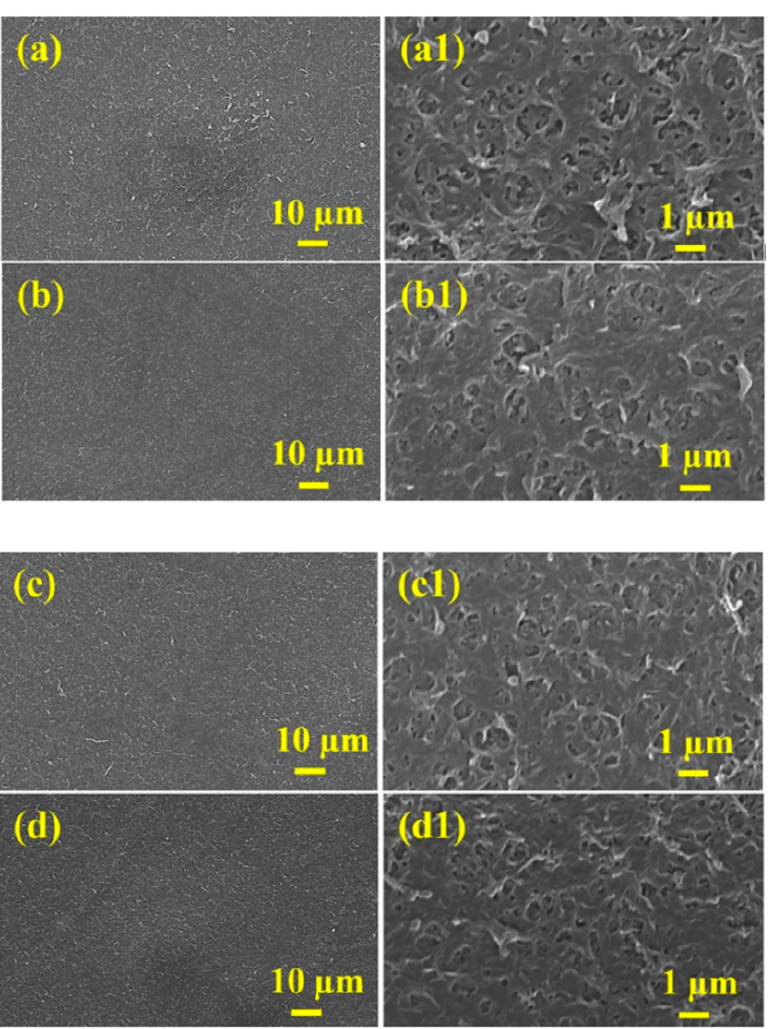
Figure 4. FESEM micrographs of ( a , a1 ) pristine M-0, ( b , b1 ) M-10, ( c , c1 ) M-20 and ( d , d1 ) M-30.